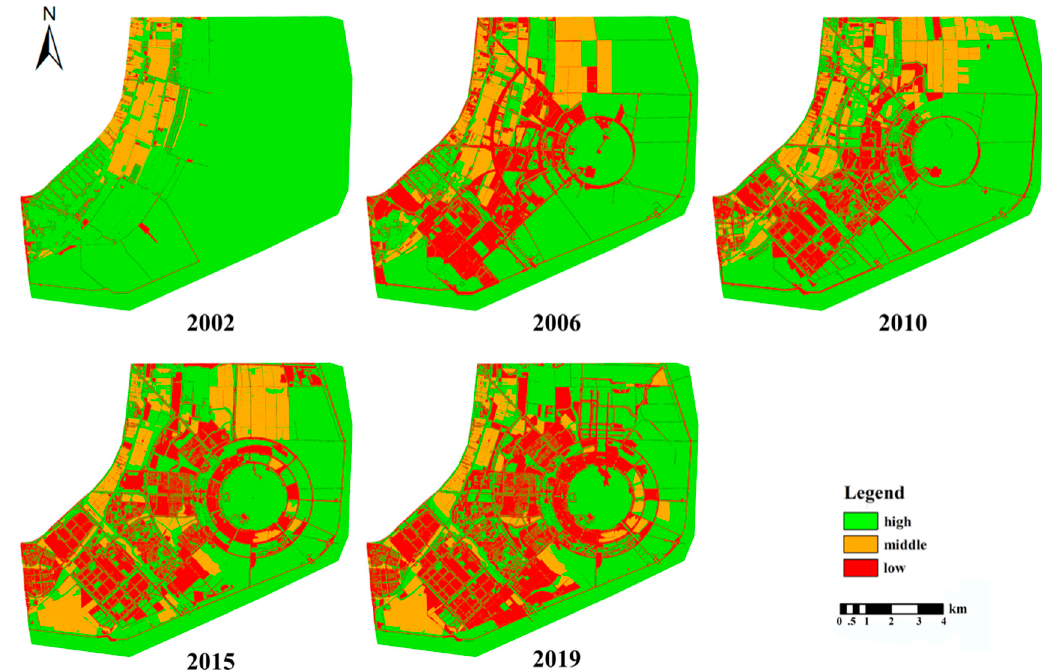
Figure 2. The spatial distribution pattern of high-, middle- and low-level habitat quality.